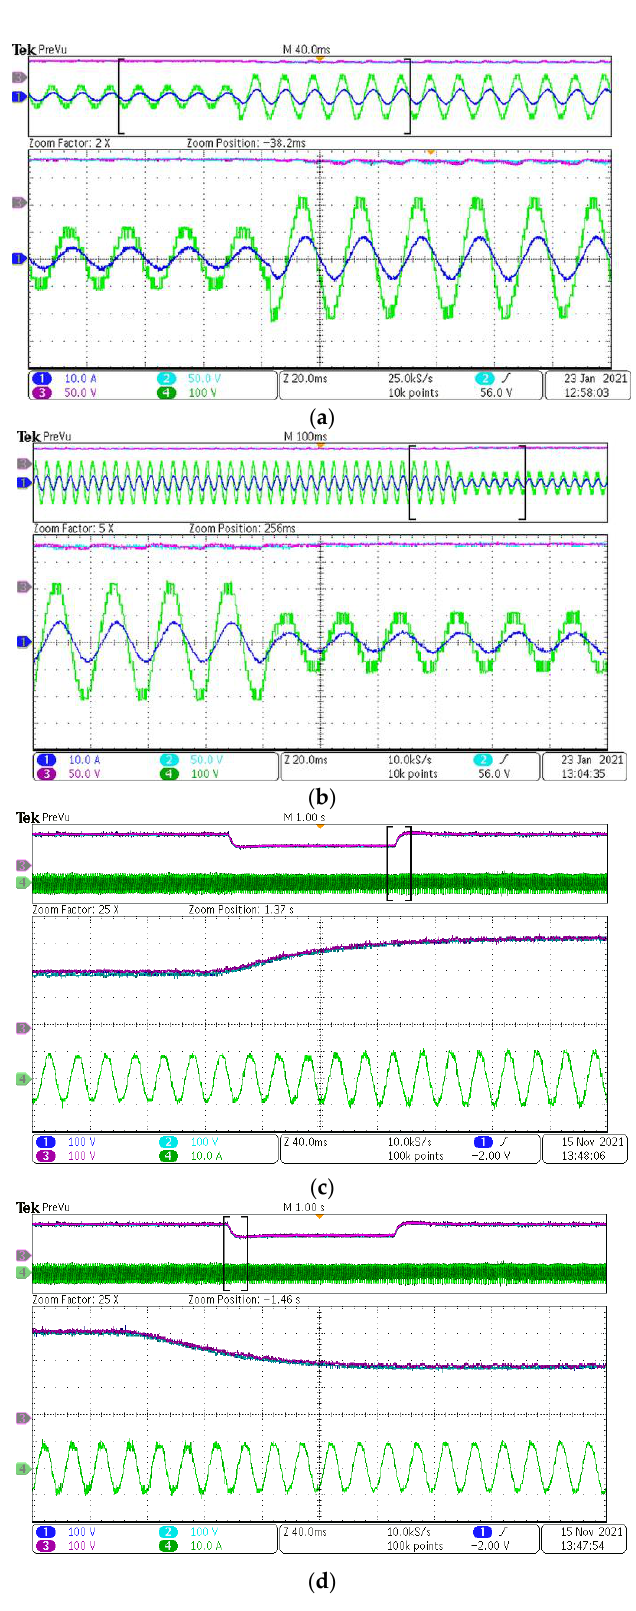
Figure 12. Experimental dynamic responses of the inverter system ( a ), ( b ) Variation in the modulation index value at constant input dc-link voltages, ( c , d ) Variation in the input dc-link voltages at constant output load current.